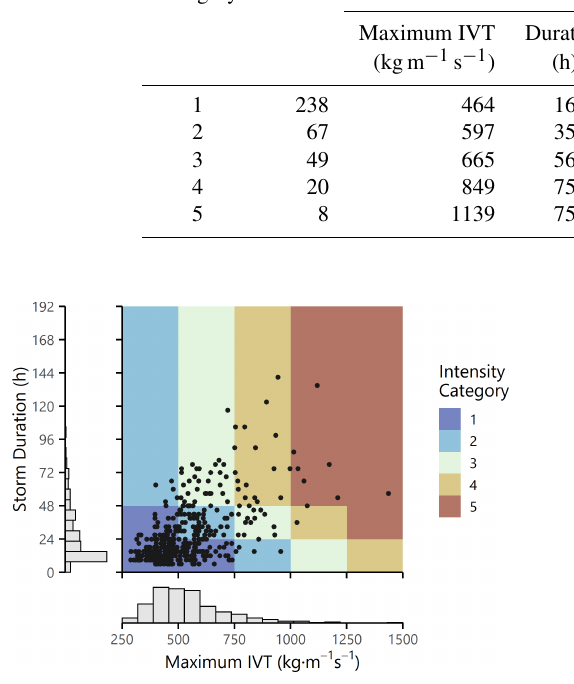
Figure 3. Summary of Sonoma County historic catalog. Each point represents one AR event recorded in Sonoma County between 1988 and 2019 ( n = 382). The Ralph et al. (2019) intensity categories are represented by the background